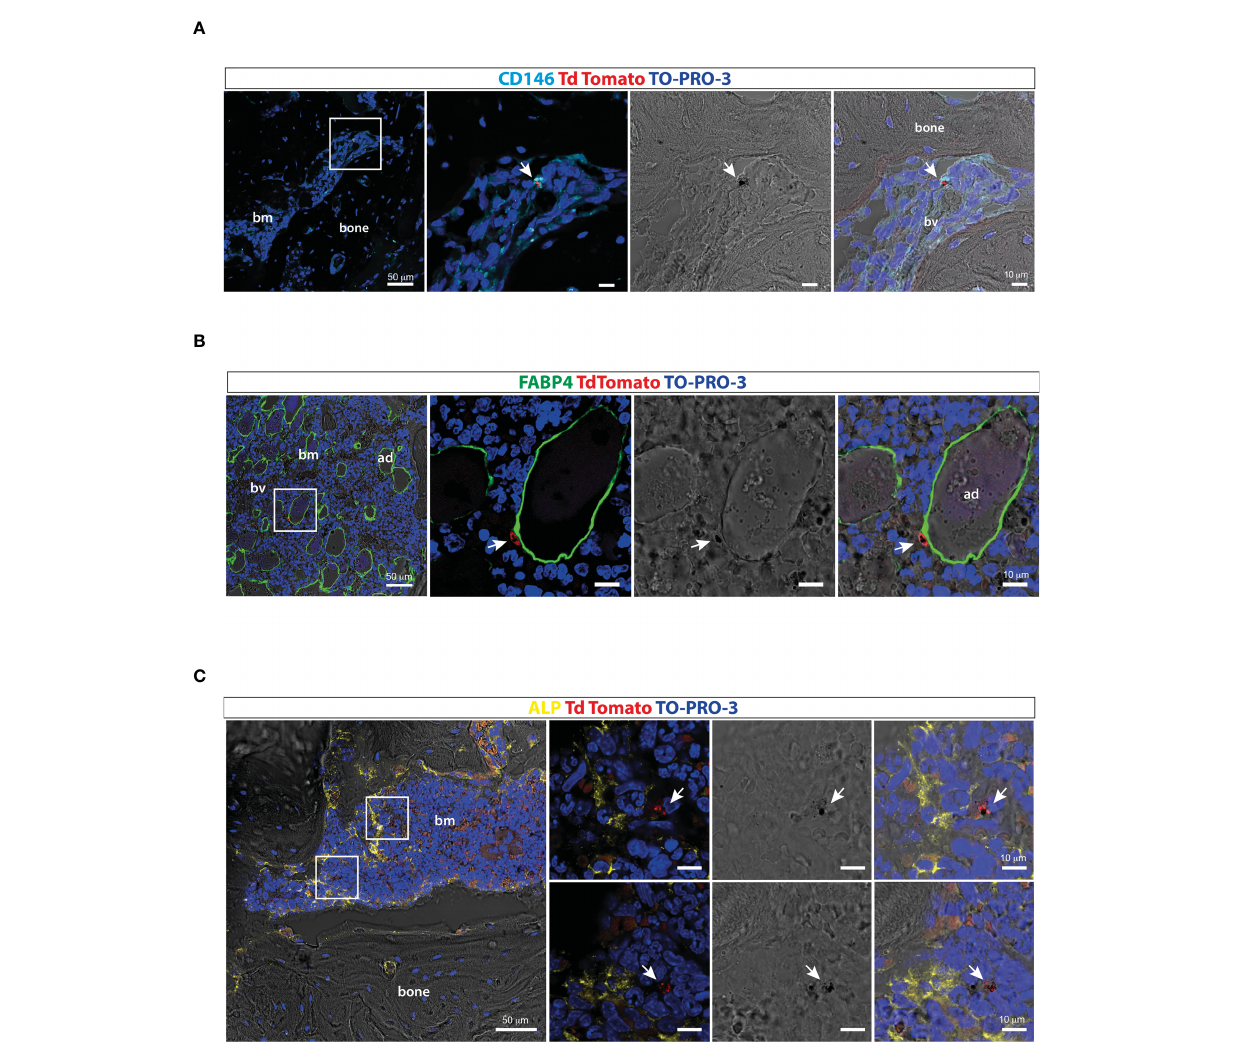
FIGURE 5 Distribution of P. falciparum stage II-III gametocytes within the ossicle bone marrow microenvironment (A) Confocal fl uorescent images of ossicle sections stained with anti-CD146 showing TdTomato positive stage II-III gametocytes in contact with a human-CD146 positive stromal cell surrounding a murine blood vessel (arrow). (B) Confocal fl uorescent images of ossicle sections stained with an anti-FABP4 antibody showing a tdTomato immature gametocytes in close contact with a human bone marrow adipocyte (arrow). (C) Confocal fl uorescent images of ossicle sections stained with an ALP antibody showing TdTomato positive stage II-III gametocytes near ALP-positive osteogenic cells (arrow). bm, bone marrow; bv, blood vessel; ad,